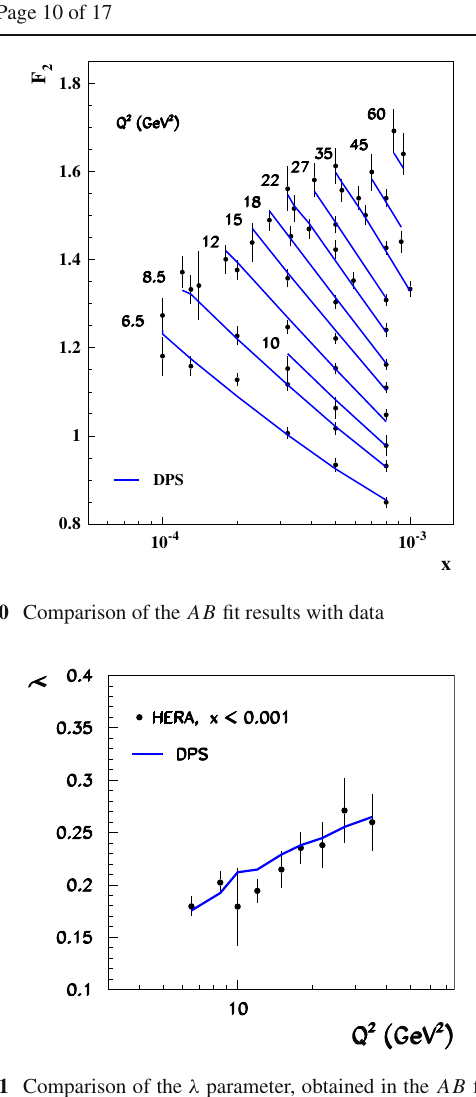
Fig. 11 Comparison of the λ parameter, obtained in the AB fit, with